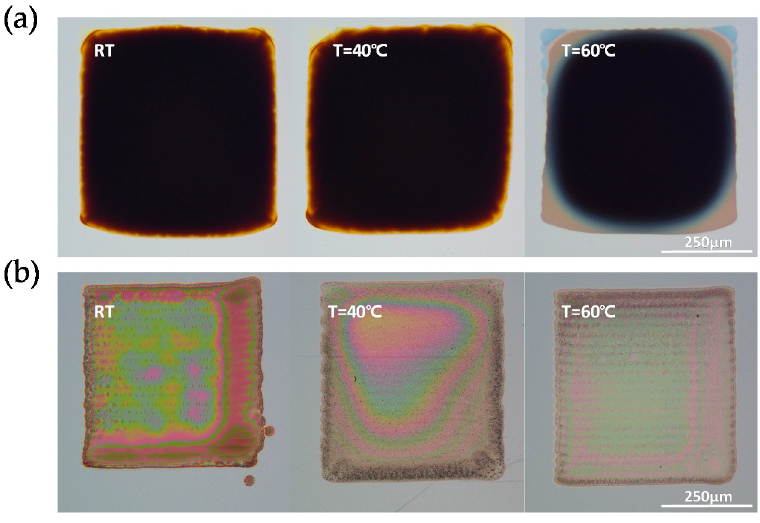
Figure 2. Inkjet printed with ( a ) silver nanoparticles ink film and ( b ) silver salt ink film on a-IGZO/Al 2 O 3 with substrate temperatures of RT, 40 °C and 60 °C , respectively.